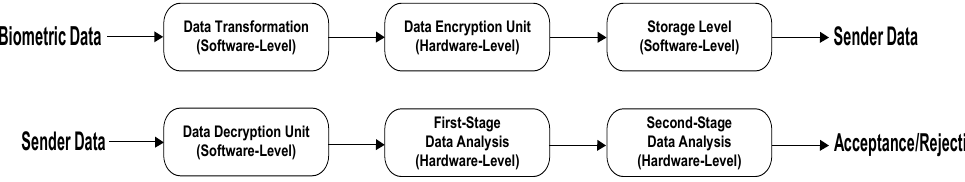
Figure 1. The architecture of the cross-layer biometric recognition